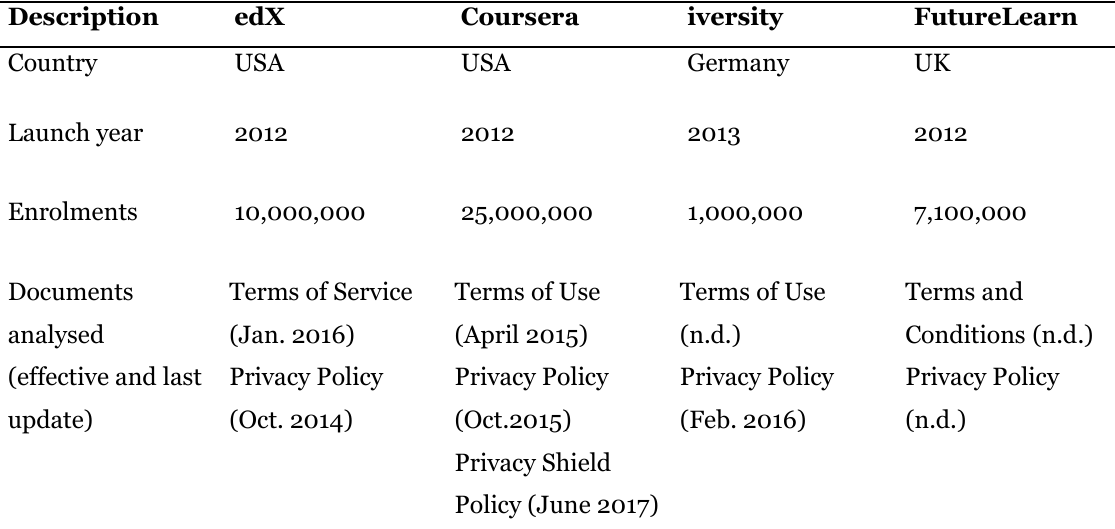
Background Information of the MOOC